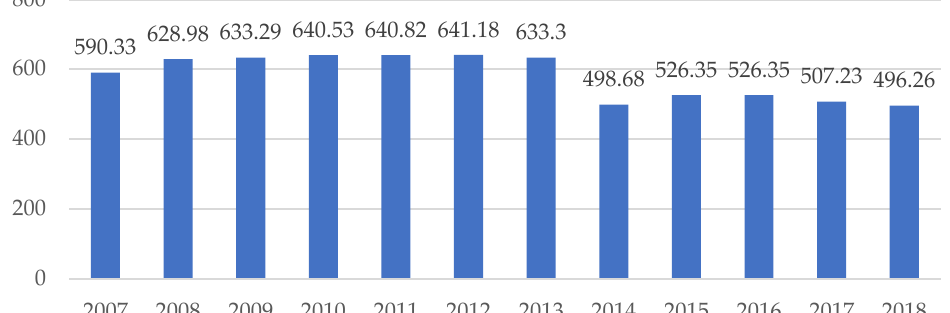
Figure 4. Forest area change in Dak Lak province, 2007–2018 (ha × 1000). Source: Reproduced with permission from Dak Lak Forest Protection Department [67].